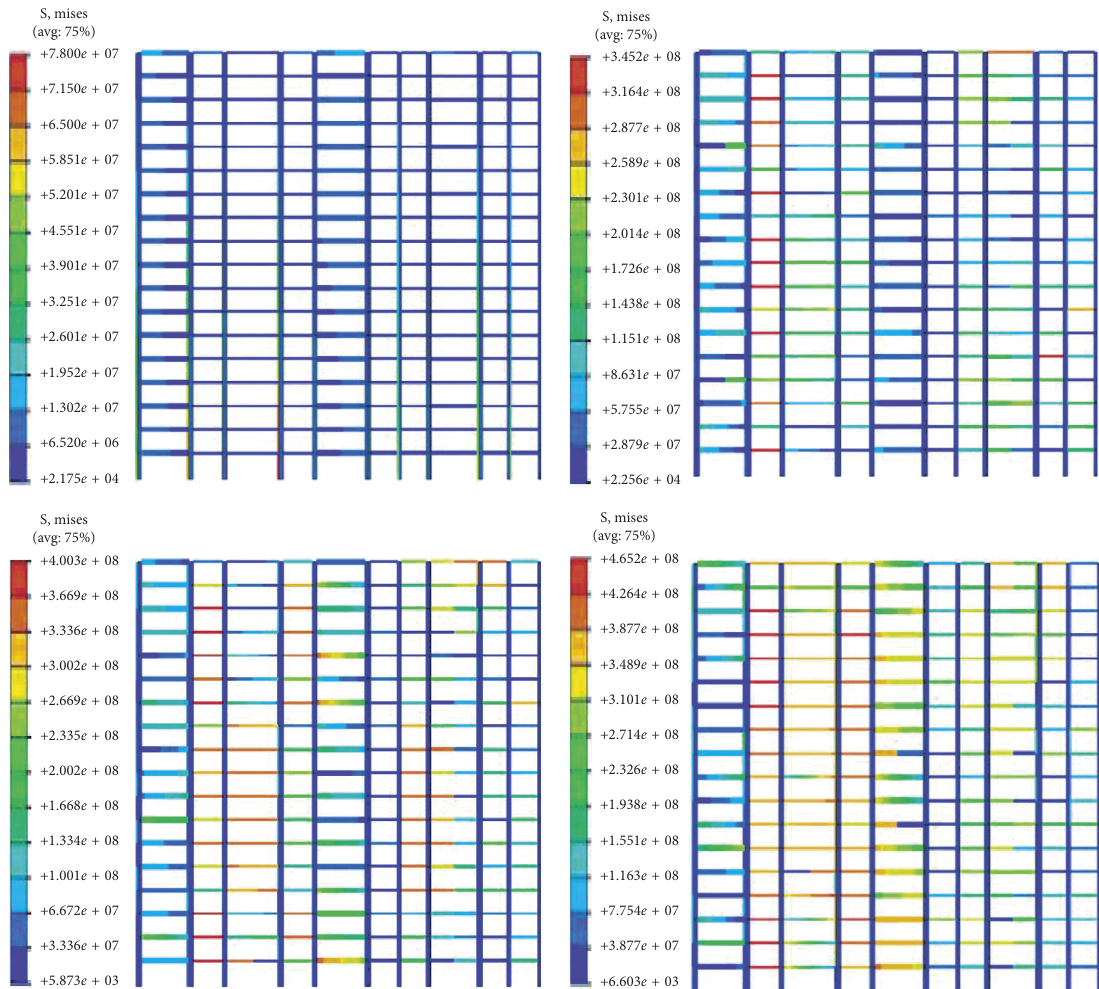
Figure 20: Stress responses of the steel of the model. (a) 3s. (b) 9s. (c) 15s. (d) 20 s.